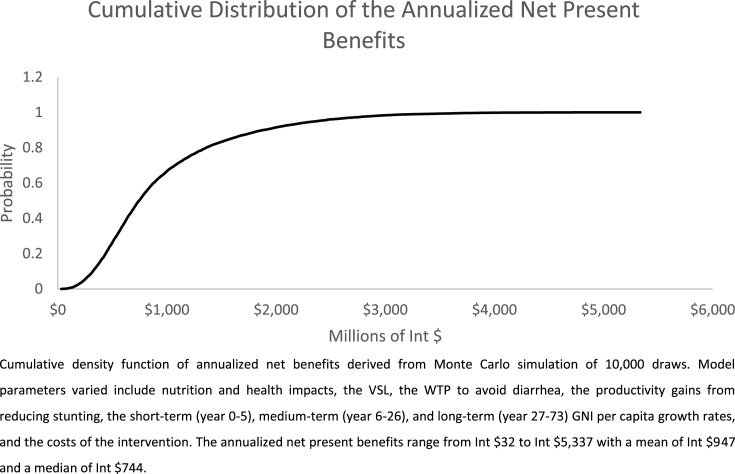
Cumulative distribution of results from a Monte Carlo simulation (10,000 draws) of a package of early childhood interventions to improve nutrition in Haiti (Net Benefits).